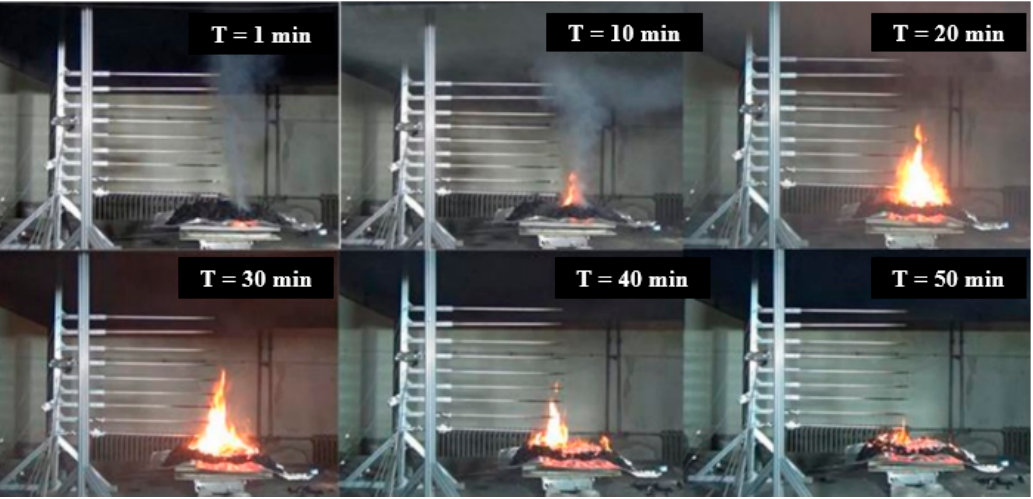
Figure 2. Burning process photographs of Test-4 at di ff erent